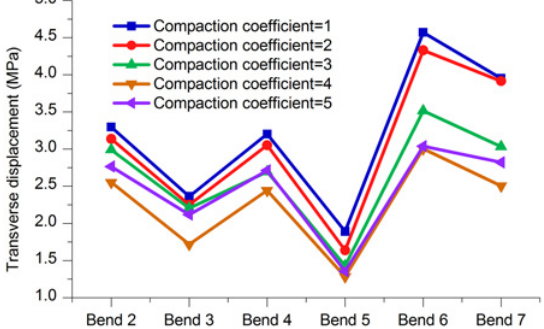
Fig 20. Lateral displacements of bends with different Compaction coefficients.